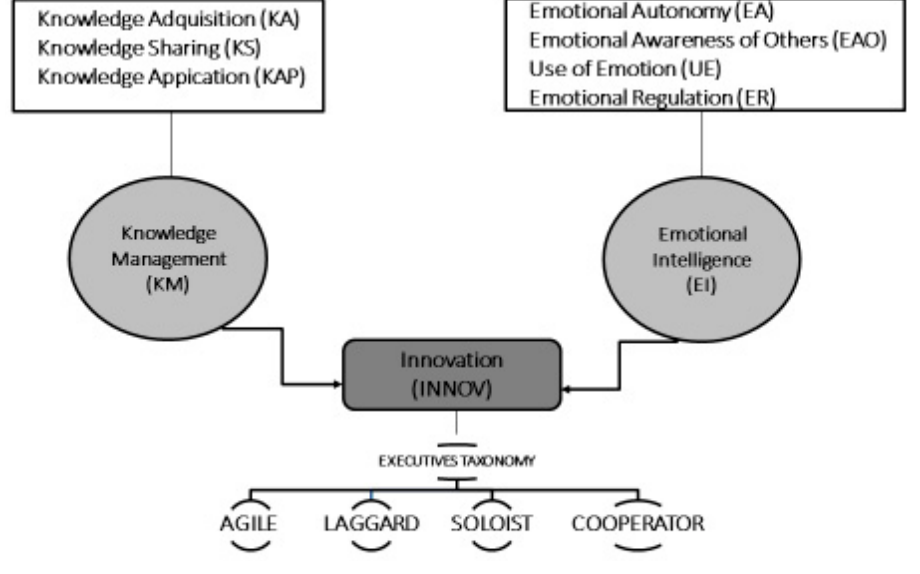
Figure 1. Research